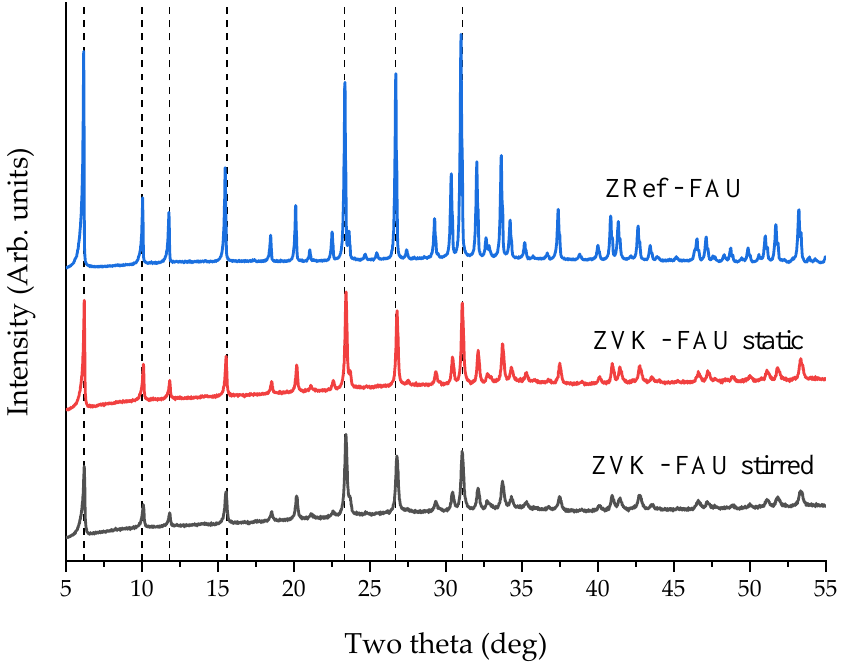
Figure 5. XRD patterns of FAU zeolites from VK (ZVK-FAU) under stirred and static ageing. Dashed lines represent main FAU zeolite peaks.